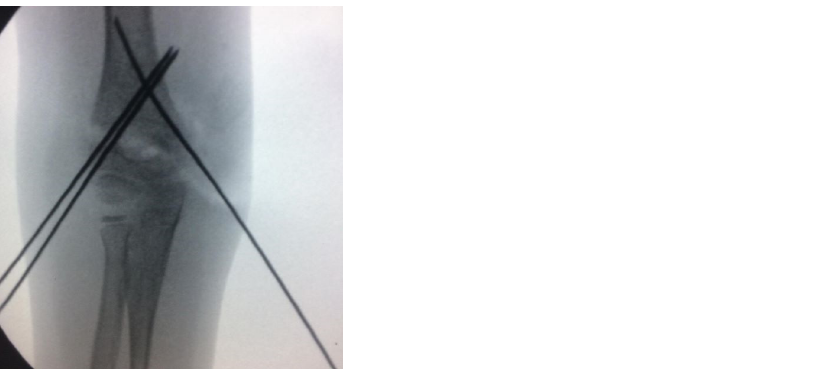
Figure 2. Two lateral and one medial pin configuration for supracondylar humeral fracture.